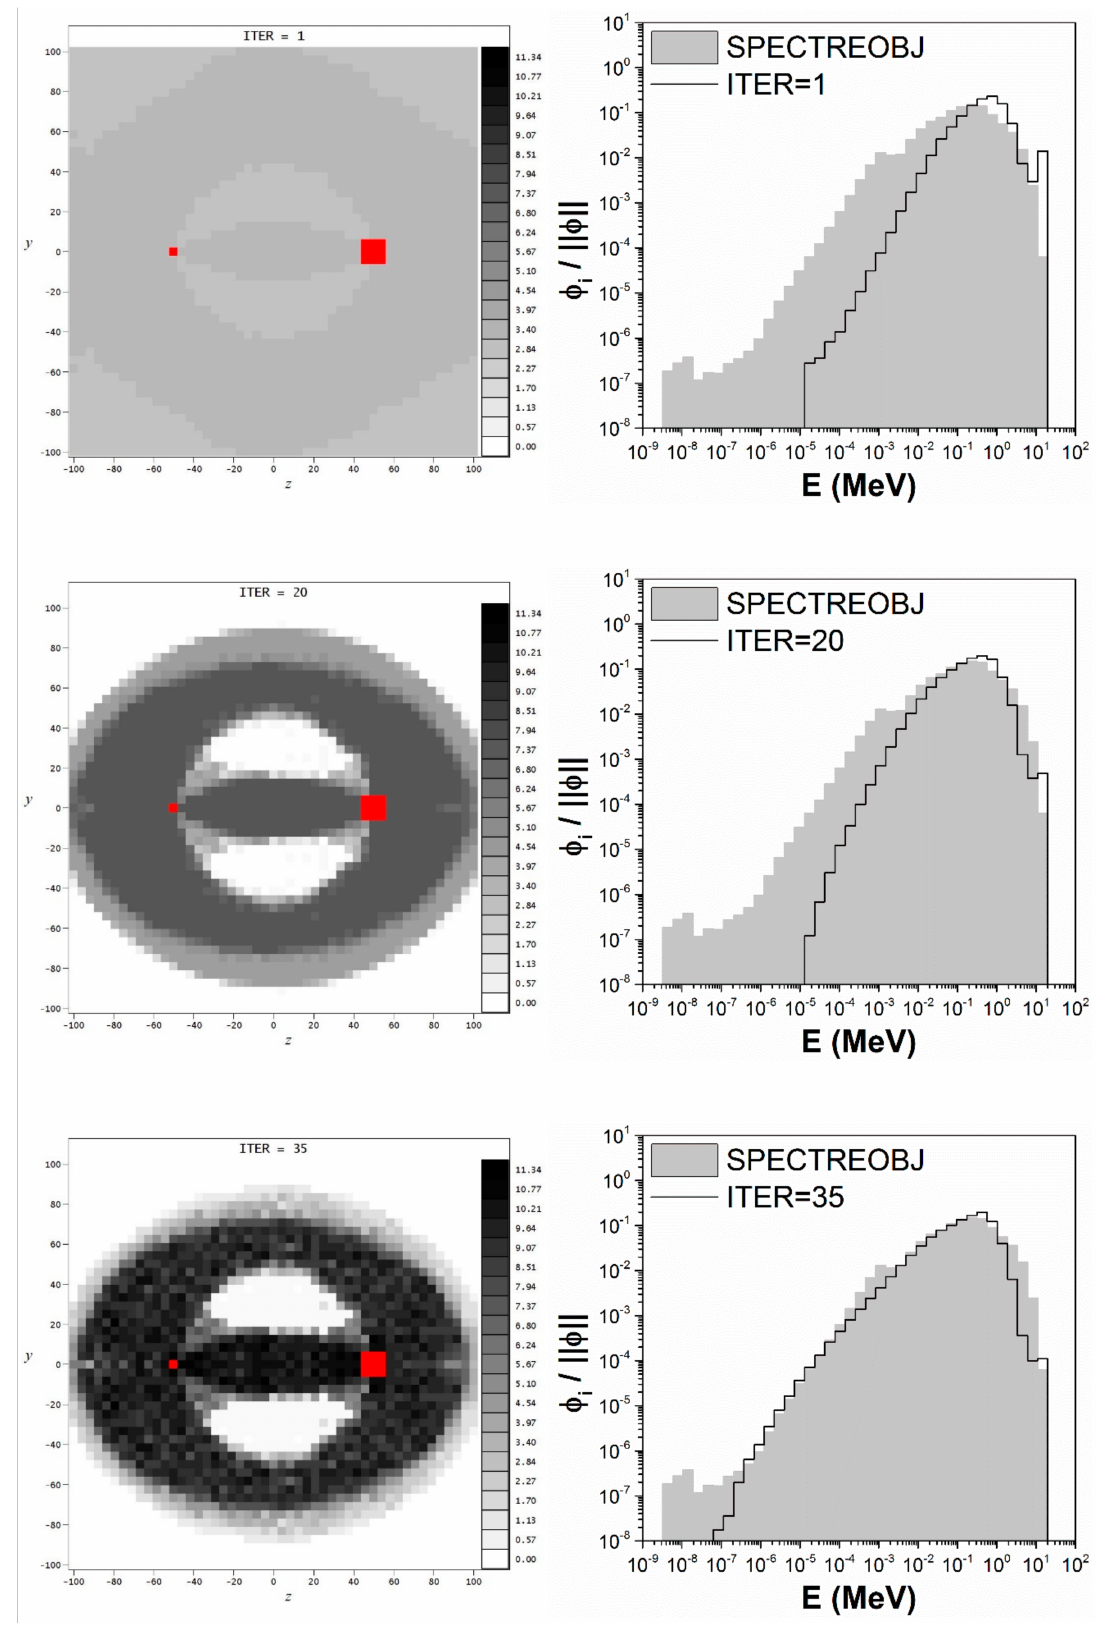
Figure 1. Iterative design of a neutron spectrum shaper with the optimization